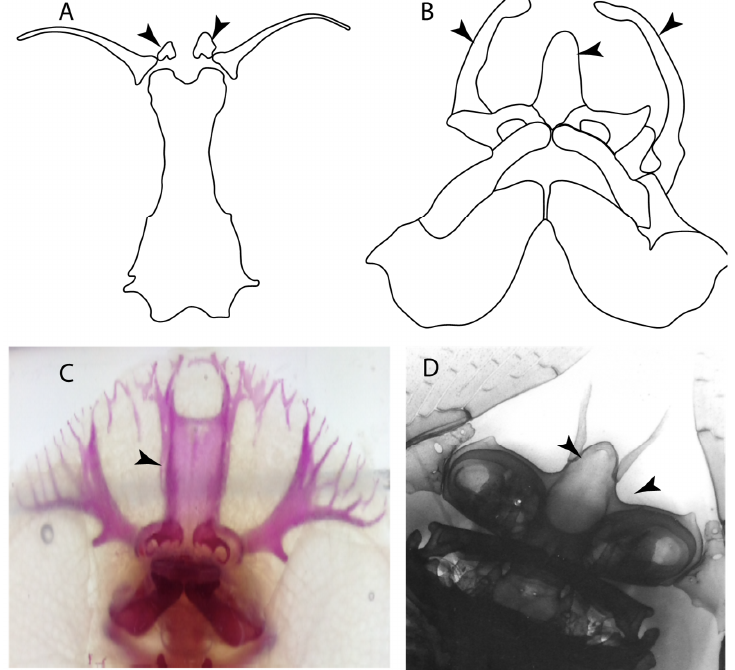
Figure 8. Neurocranium of selected torpediniforms: State (0): ( A ) Interpretative line drawing of Hyp- nos subnigrum (MCZ S985, modified from Claeson Text-Figure 3.17A in[71]. State (0 and 1): ( B ) Interpretative line drawing of Narke sp. (ZMB 33911, modified from Claeson Text-Figure 3.17J in [71]. State (2): ( C ) Narcine brasiliensis (CNPE-IBUNAM 9280); ( D ) Platyrhina triseriata (MNHN 4329). Arrowheads indicate the lateral rostral process.